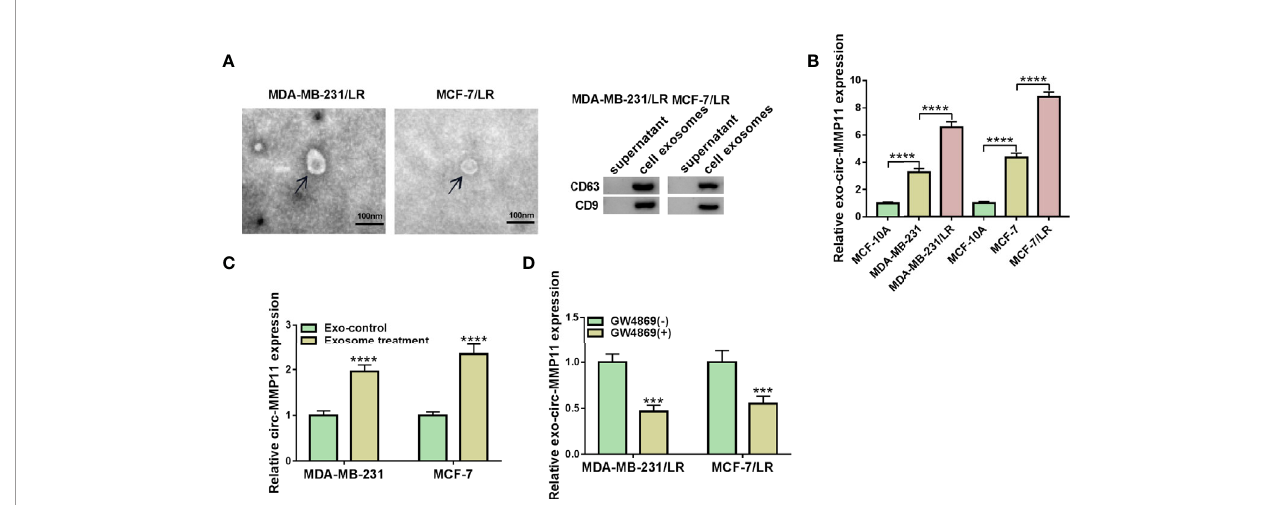
FIGURE 2 | Exosomal circ-MMP11 was increased in LR breast cancer cells. (A) Transmission electron microscope was employed to analyze the exosome from the cell culture medium of MDA-MB-231/LR and MCF-7/LR cells. And exosomal markers CD63 and CD9 were detected by western blot assay. (B) Circ-MMP11 level was measured in MCF-10A, MDA-MB-231, MDA-MB-231/LR, MCF-7, MCF-7/LR cells. (C) Relative circ-MMP11 expression was assessed in MDA-MB-231 and MCF-7 cells treated with control or exosome. (D) Circ-MMP11 level was tested in the corresponding cultured media of MDA-MB-231/LR and MCF-7/LR cells treated with or without GW4869. *** P < 0.001, **** P < 0.0001 (ANOVA with Tukey ’ s tests), circ-MMP11 relative to GAPDH.